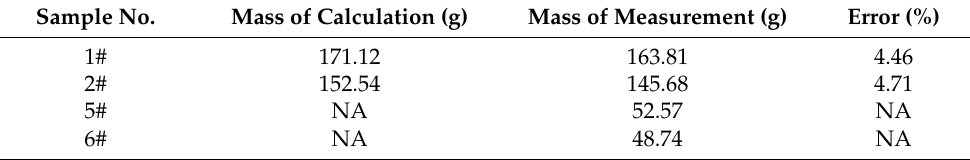
Table 8. Mass calculation.